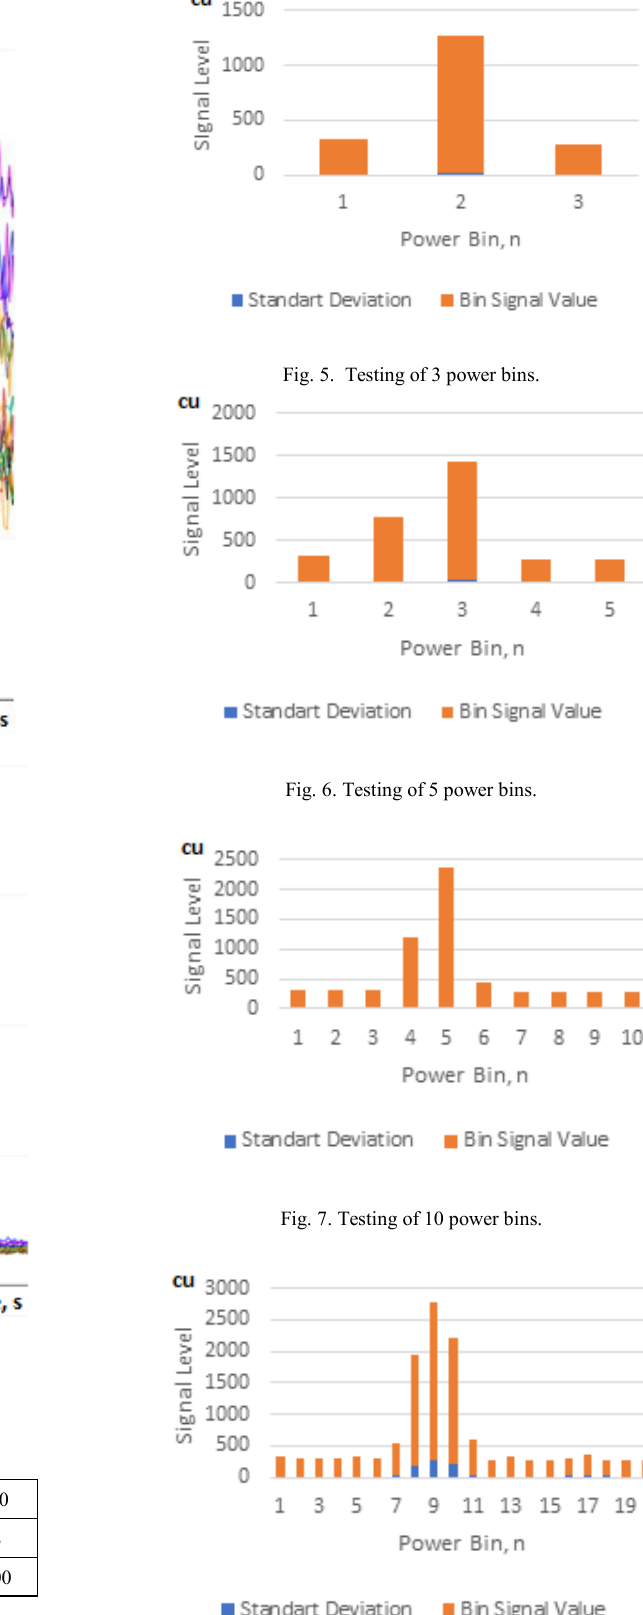
Fig. 8. Testing of 20 power